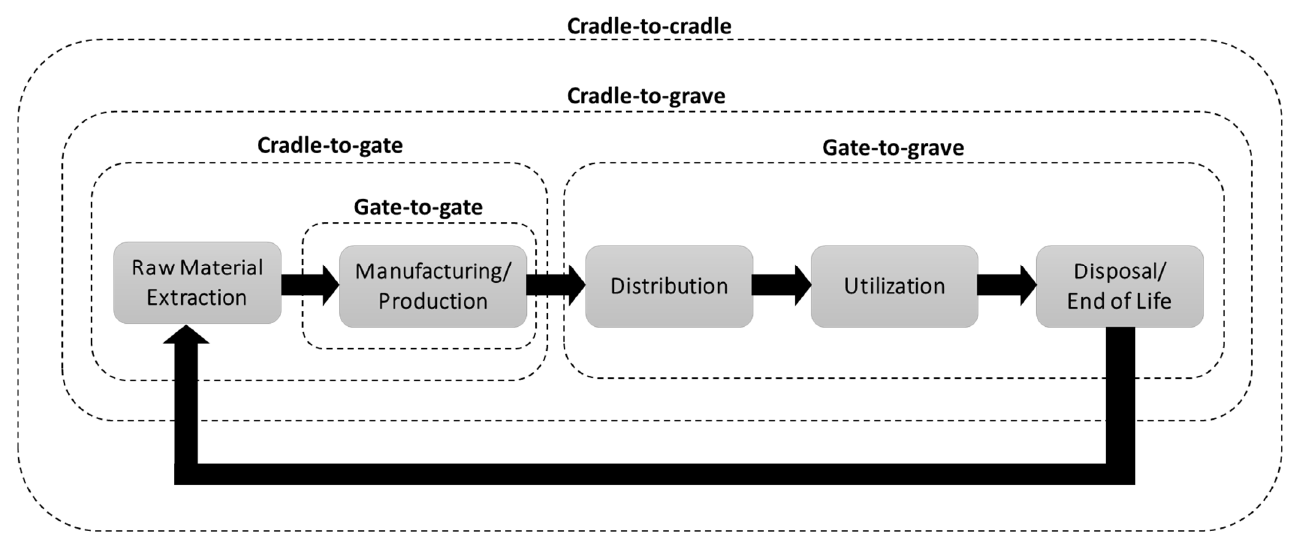
Figure 2. Scope of LCA.